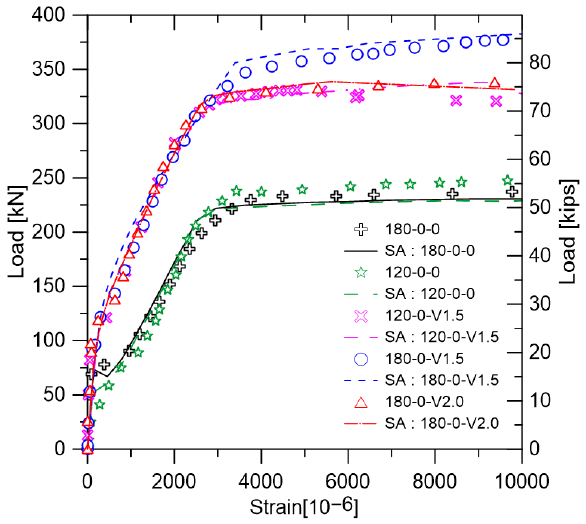
Figure 11. Sectional analysis results.